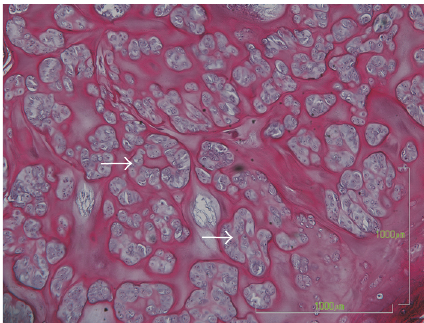
Figure 4: Histological section with haematoxylin and eosin stain- ing. Clustered chondrocytes were observed in hyaline cartilage tissue